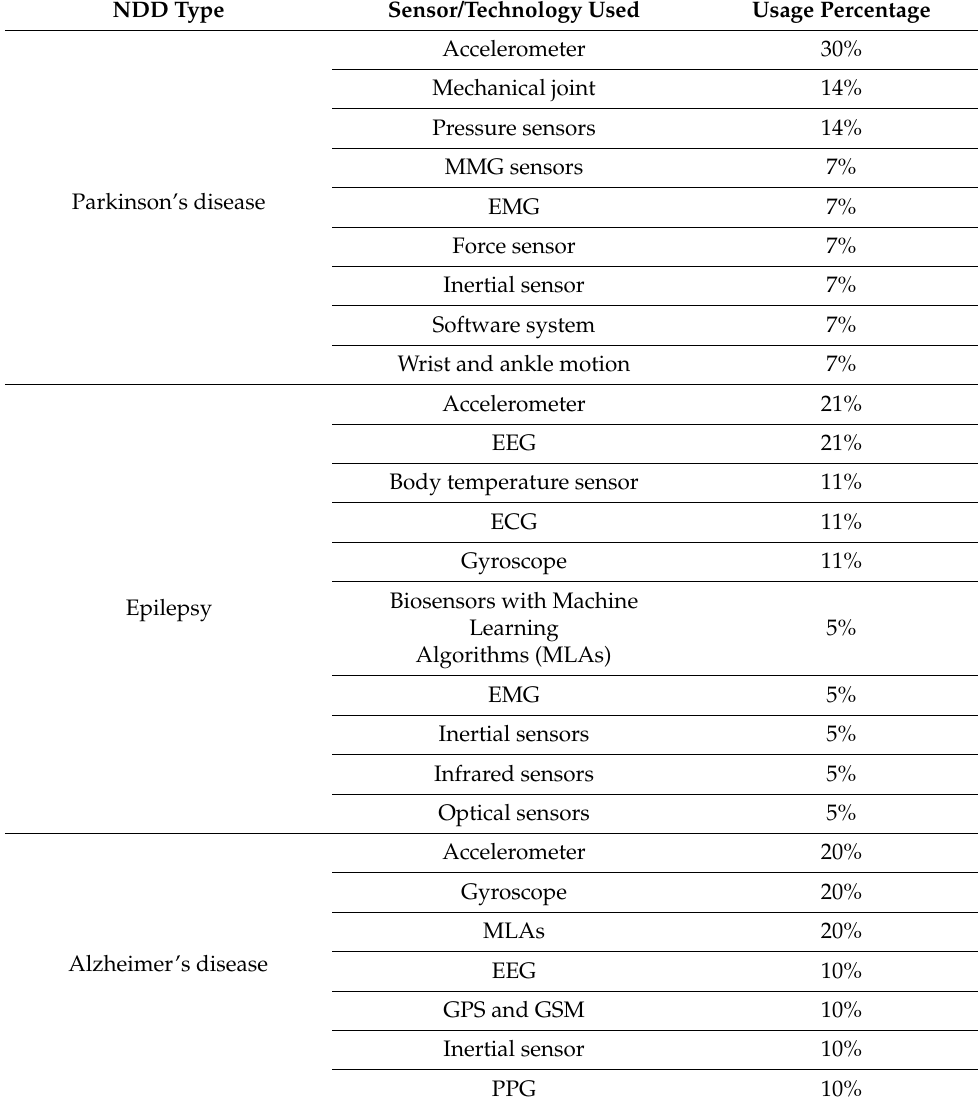
Table 7. Technology in Non-Commercial Wearables for Motoring NDD-Related Motor